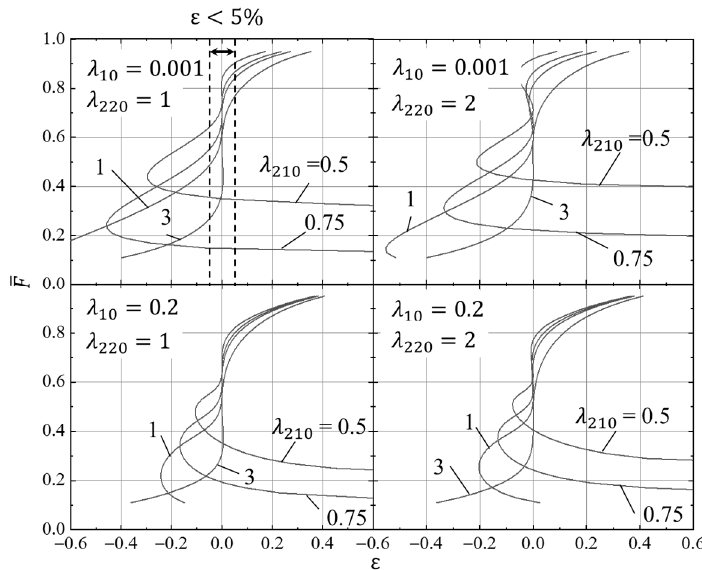
Figure 5. The effect of λ 210 on the static characteristics of the oil pad. The effect of F on ε in a single plane oil pad is calculated under different λ 220 for four combinations of parameters λ 10 , λ 210 . Referring to Figure 6, the relative displacement of the oil pad ε can be maintained close to 0 for a wide range of loads when λ 220 > 0.5. However, ε is so sensitive to F when λ 220 < 0.5 that it cannot meet the demand.